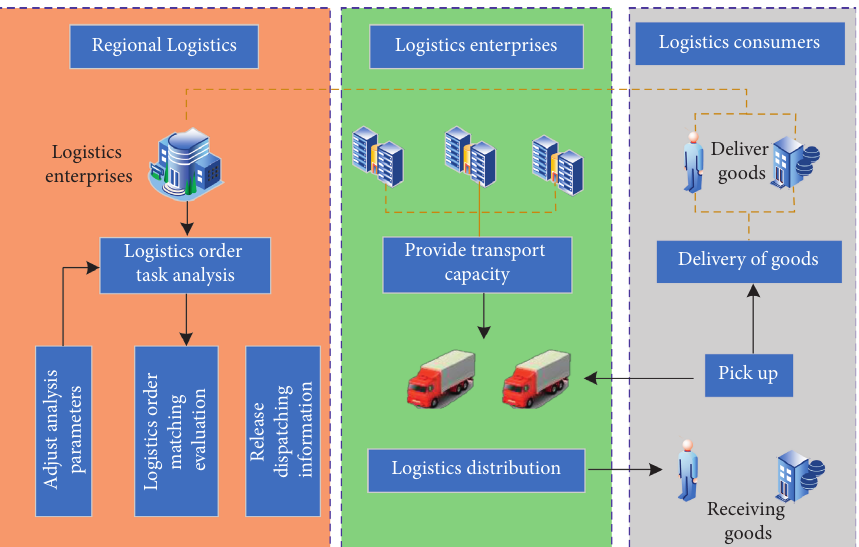
Figure 4: The mode of regional logistics collaborative distribution